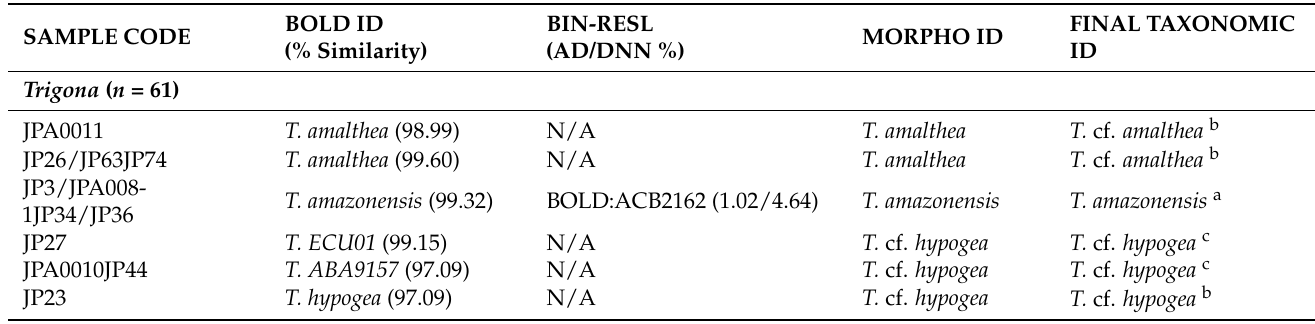
Table 1. List of collected Peruvian stingless bees with their final identification obtained by integrating DNA barcoding, morphology, and inspection of COI phylogenetic trees. Final taxonomic IDs were established as follows: a Specimens ascribed to a species with BOLD ID % similarity > 97, confirmed by morphology and with sequences included in a monophyletic clade with all conspecifics (with node score > 70) received the “BOLD ID attribution”; b Specimens ascribed to a species with BOLD ID % similarity > 97, confirmed by morphology, but whose sequences were interspersed but grouped in various monophyletic clades (node score > 70) embedding conspecifics were named as “cf. + BOLD ID attribution” or “cf. + BOLD attribution + clade ID” when referring to clades grouping only Peruvian specimens; c Specimens unidentified at the species level in BOLD, but belonging to a clade (node score > 70) including at least one identified ( a, b ) specimen at the species level, and confirmed by morphology, were named as “cf. + BOLD ID attribution of the sister taxon”; d Specimens with BOLD and/or morphologically-based species attributions, not examined on reconstructed phylogenetic trees due to lack or strong underrepresentation of BOLD data, received a final (but uncertain) taxonomic ID provided by authors; * Unidentified specimens at species level in BOLD and by morphology, forming an independent clade in the phylogenetic tree were named as “genus +